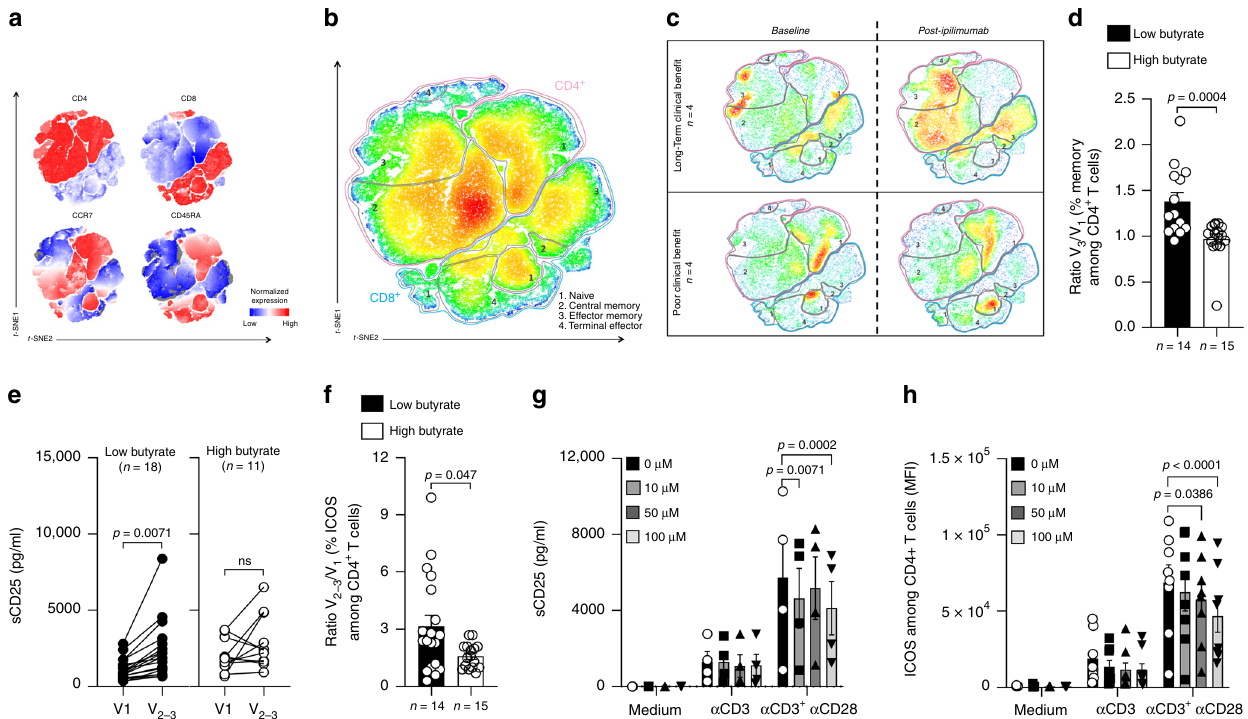
Fig. 6 Immune markers during the course of ipilimumab. a t -SNE map of markers included in the T cell 1 panel in all patients ( n = 8). b t -SNE map with the gating of T cell (CD3 + ) populations: CD4 + T cells (red outline), CD8 + T cells (blue outline), black outlines (regions 1 : Naive CD4 + or CD8 + T cells; regions 2 : Central memory CD4 + or CD8 + T cells; region 3 : Effector memory CD4 + or CD8 + T cells; regions 4: Terminally effector CD4 + or CD8 + T cells). c t -SNE map at baseline (V 1 ) and post-ipilimumab (V 2-3 ) in patients with long-term clinical bene fi t (upper panel) and poor clinical bene fi t (lower panel). d Post-ipilimumab (V 3 ) to baseline (V 1 ) ratio (Ratio V 3 /V 1 ;) of memory CD4 + T cells (% among CD4 + T cells) according median concentration of serum butyrate at baseline. e Serum concentration of sCD25 was monitored before ipilimumab treatment (V 1 ) and after one or two injections of ipilimumab (V 2 – 3 ) according to butyrate concentration. f As in ( d ) but for ICOS + CD4 + T cells (% ICOS + among CD4 + T cells;) . g sCD25 quanti fi cation in the supernatants of PBMC after 4 days of culture in medium + / − plastic-bound anti-CD3 ε + / − anti-CD28 agonist with escalating dose of butyrate (n = 4). h As in ( g ) but ICOS mean fl uorescence intensity (MFI) among CD4 + T cells ( n = 8). Histograms represent mean + /- sem ( d , f , g and h ). Each dot represents one patient. n are indicated on graphs; p -values are indicated on each graph; Wilcoxon ( e ) and Mann – Whitney ( d , f ) and two-way RM ANOVA followed by Tukey ’ s tests for multiple comparisons was used ( g , h ) tests were used. Exact p -values are indicated on each graph otherwise * p <